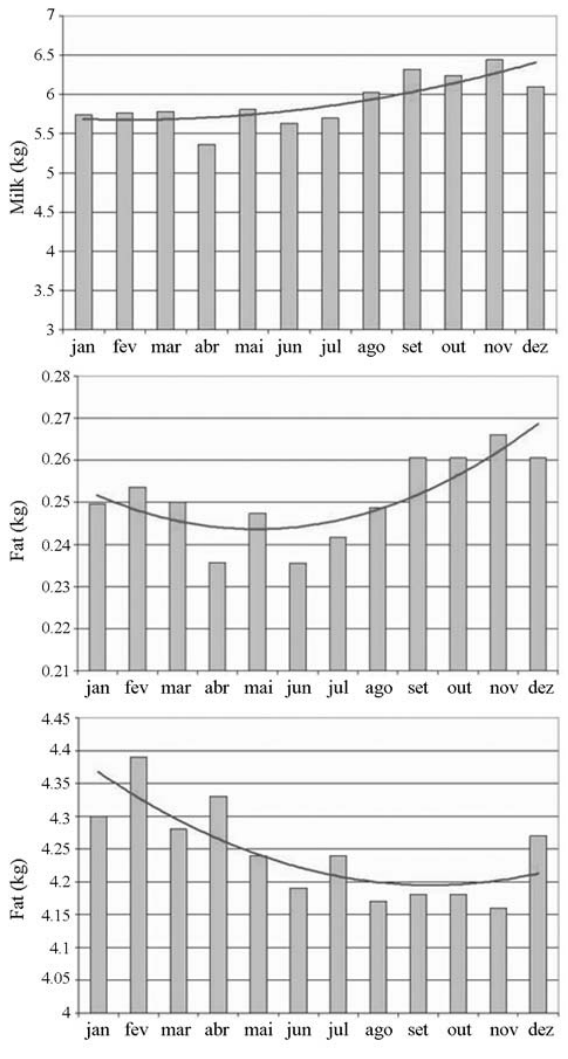
Figure5 -Effectsmonthofcalvingonmilkyield(MY),fatyield(FY)and fat percentage (FP) of crossbred Holstein-Zebu